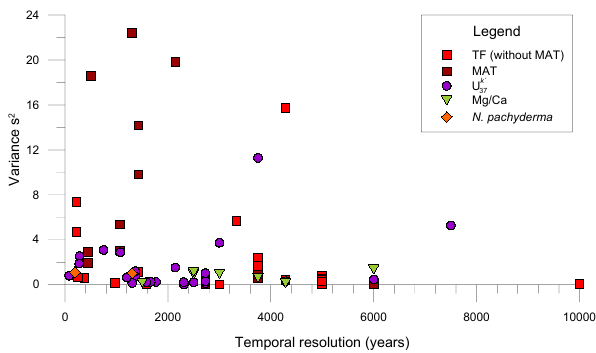
Fig. 11. Variances of the proxy SST records versus their temporal resolution. High variances in the SSTs are found in low-resolution records particularly estimated with the modern analog technique while most of the other records show lower variances with higher